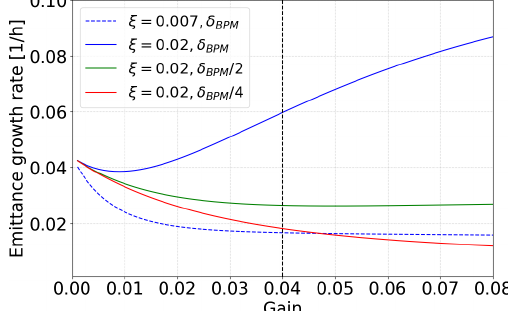
FIG. 10. Extrapolation of the emittance growth rate based on Eq. (1) and the parameters obtained empirically to a configuration featuring a reduced beam-beam tune shift with respect to the experiment. The potential impact of a reduction of the feedback noise by a factor 2 and 4 is also shown. Avertical dashed line was added to indicated the current operational feedback gain.